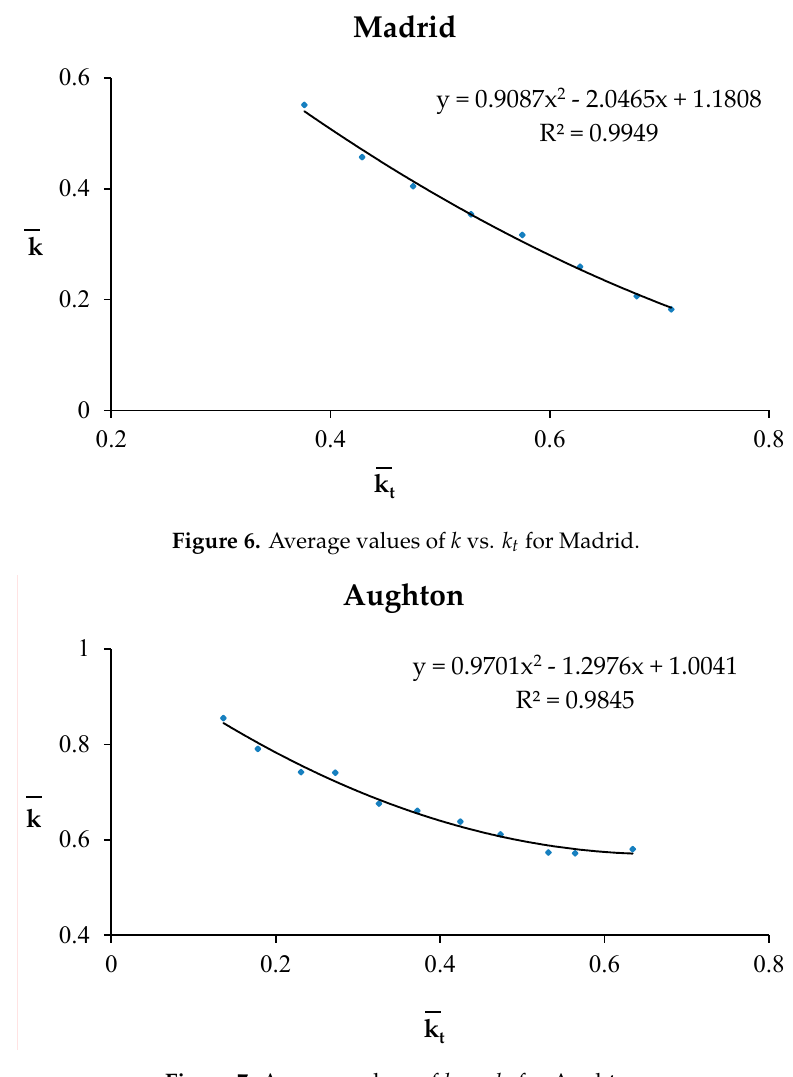
Figure 7. Average values of k vs. k t for Aughton.